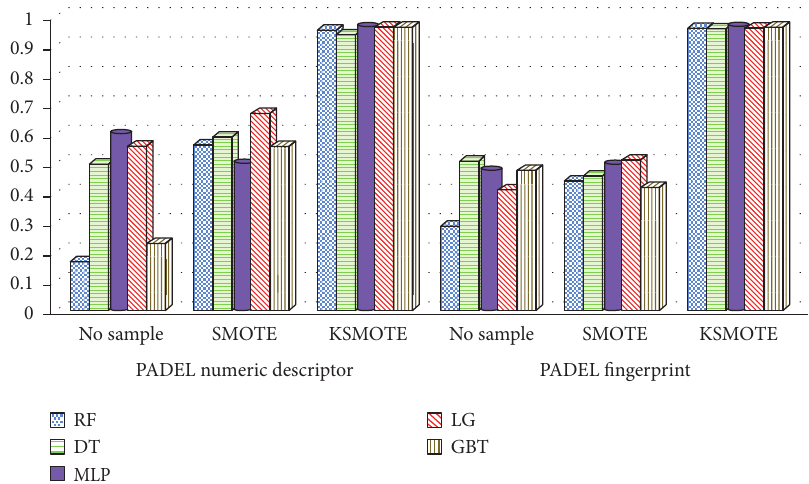
Figure 4: G-mean of PaDEL descriptor and fingerprint for AID 440.